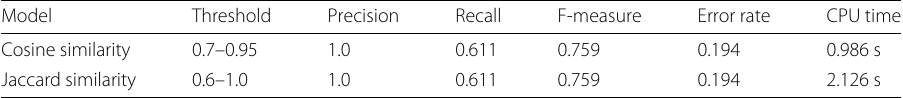
Table 4 Model comparison between text preprocessing